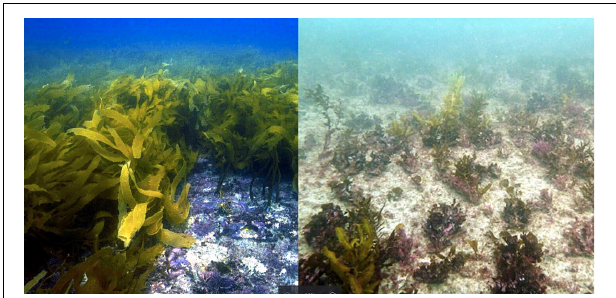
FIGURE 1 | Example of Ecklonia radiata kelp forests (left) replaced by turf algae (right) . Putative drivers include increased nutrients, and inhibition of kelp recruitment by the turf algae and entrained sediments. Photos by TW.